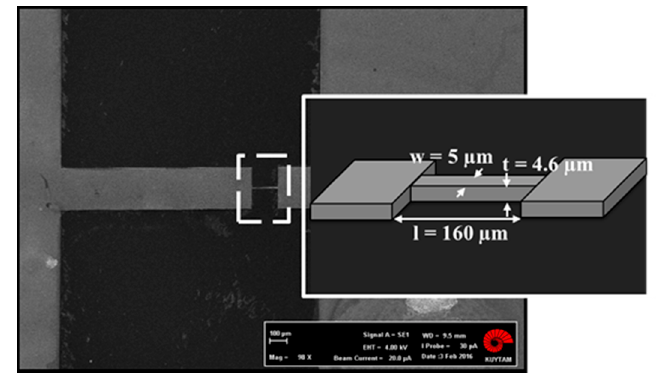
Figure 2. SEM image of Ni microresonator.